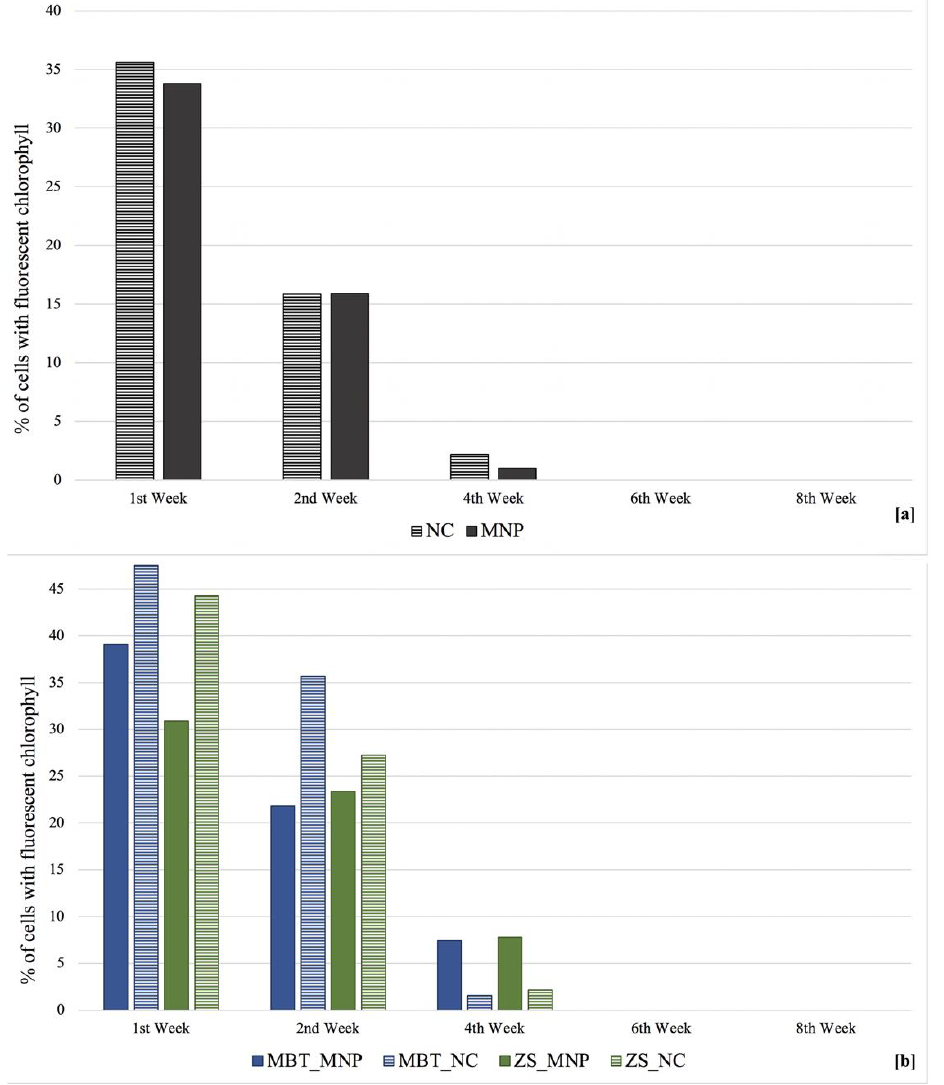
Figure 3. Evaluation of biocide efficiency of nanocontainers not loaded (NC; MNP) and loaded with the biocides (NC_ZS; NC_MBT; MNP_MBT; NC_MBT), where the decrease in fluorescent cells’ percentage highlights the efficiency of products. ( a ) Graph of red fluorescence percentage of culture treated with non-loaded nanocontainers. ( b ) Graph of red fluorescence percentage of culture treated with loaded nanocontainers.